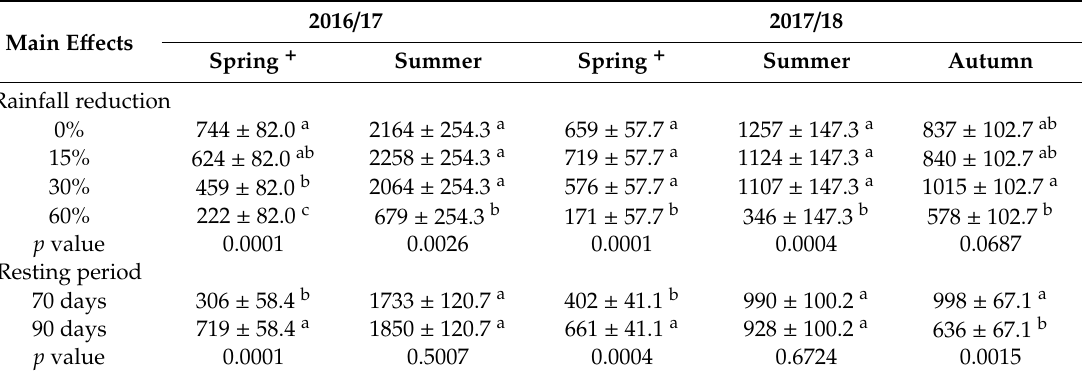
Table 5. Main e ff ect of resting period and rainfall reduction on grass (mean ± S.E) aboveground biomass yield (kg.ha − 1